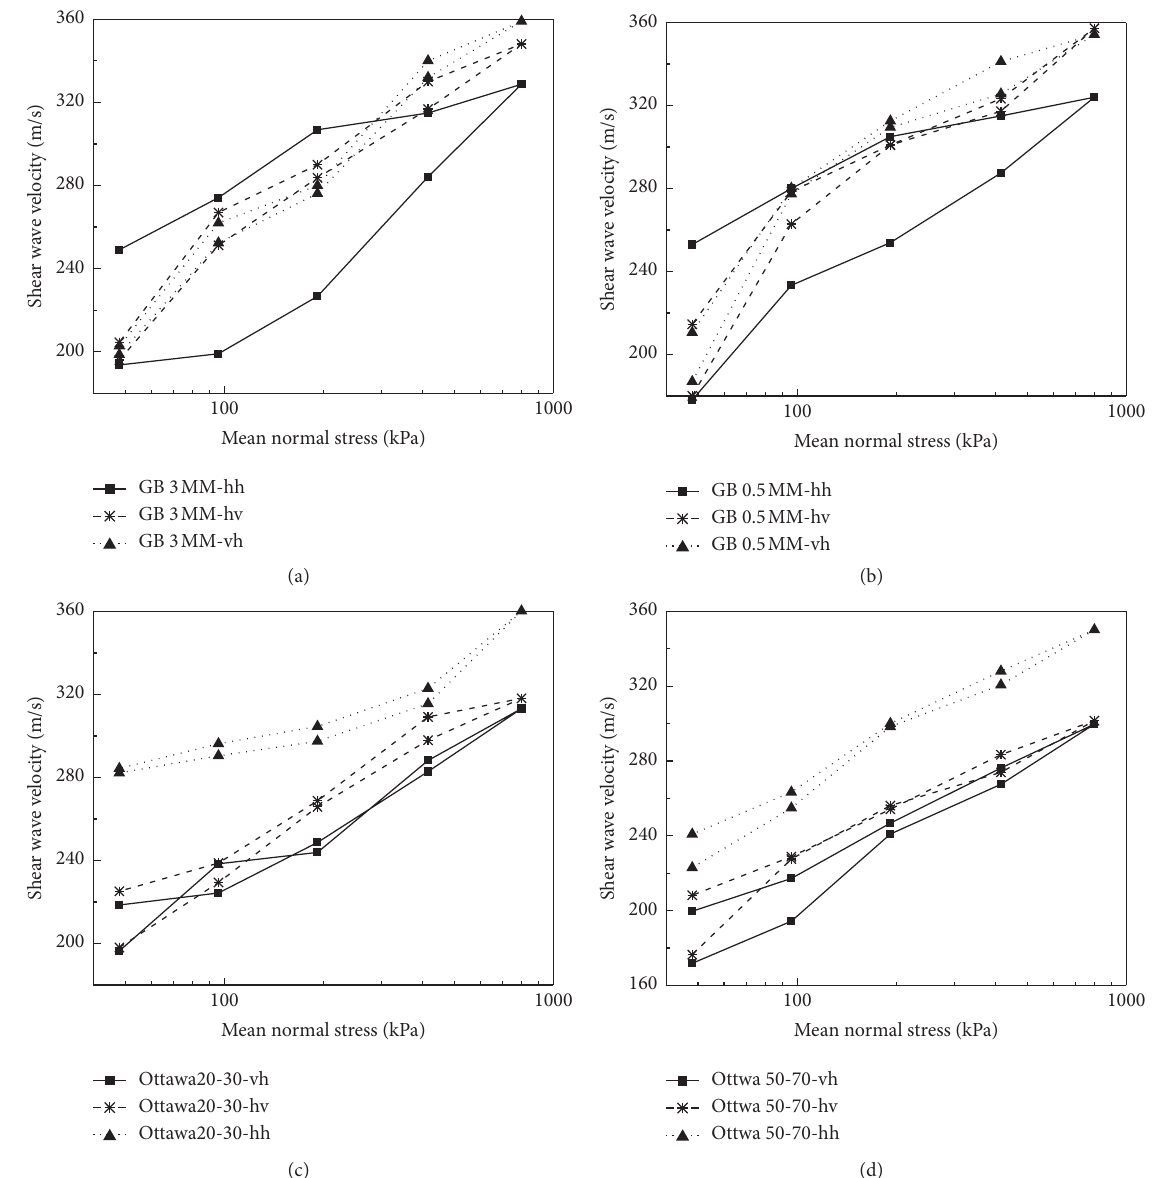
Figure 4: Shear wave velocity change during loading and unloading stages: (a) GB 0.5mm sample; (b) GB 3 mm sample; (c) Ottawa 20–30 sand sample; (d) Ottawa 50–70 sand